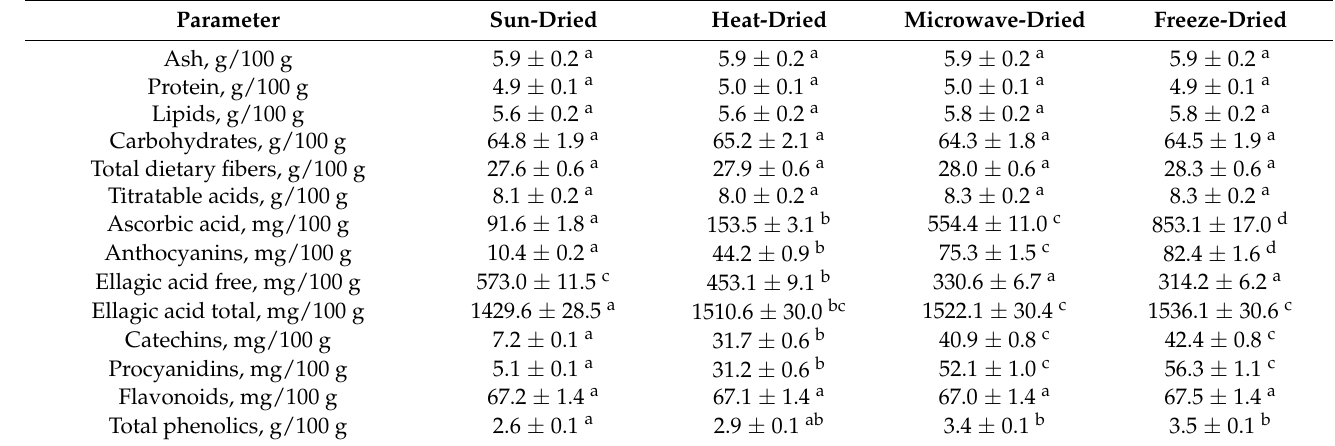
Table 6. Nutritional and chemical composition of dried F. orientalis fruits ( ±